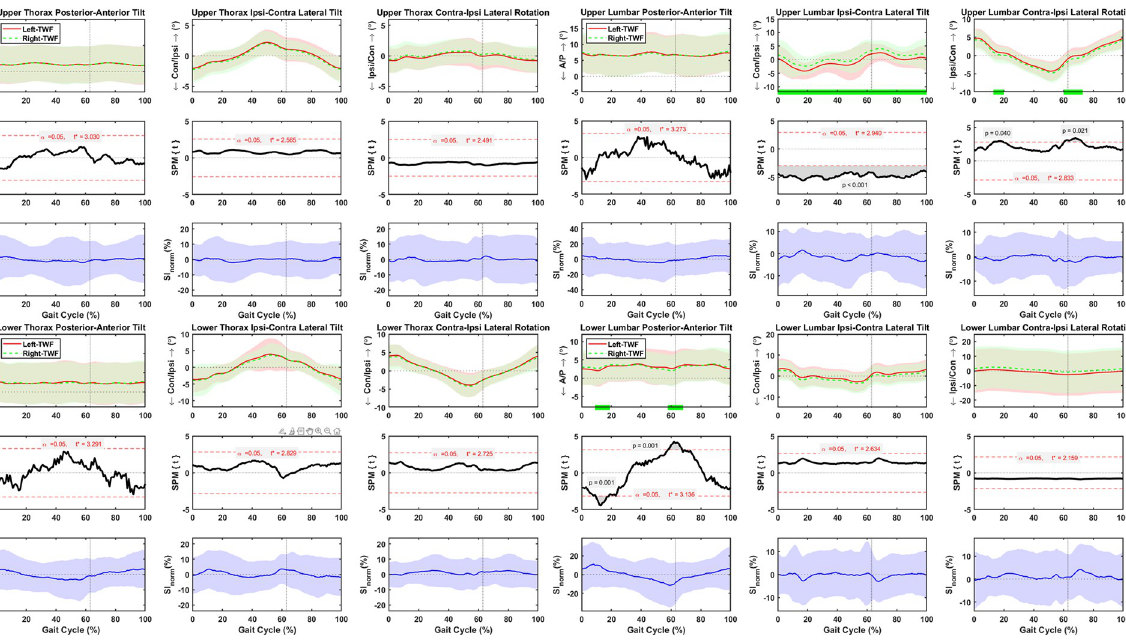
Fig 4. Average and standard deviation of upper thorax, lower thorax, upper lumbar, and lower lumbar flexion-extension (F/E), left-right (L/ R) lateral flexion, and (L/R) rotation, for left and right sides during one gait cycle of fast treadmill walking (TWF) in sixty healthy participants. Green bars on the horizontal axis and the scalar field SPM results with threshold t � depict where, in % cycle, left side angles were greater or lesser than right side angles. The normalized symmetry index (SI norm ) calculated during one gait cycle of TWF. Solid and dashed lines correspond to average left and right sides, as well as average SI norm , and shaded areas correspond to standard deviation. Black dotted vertical lines denote toe-off.